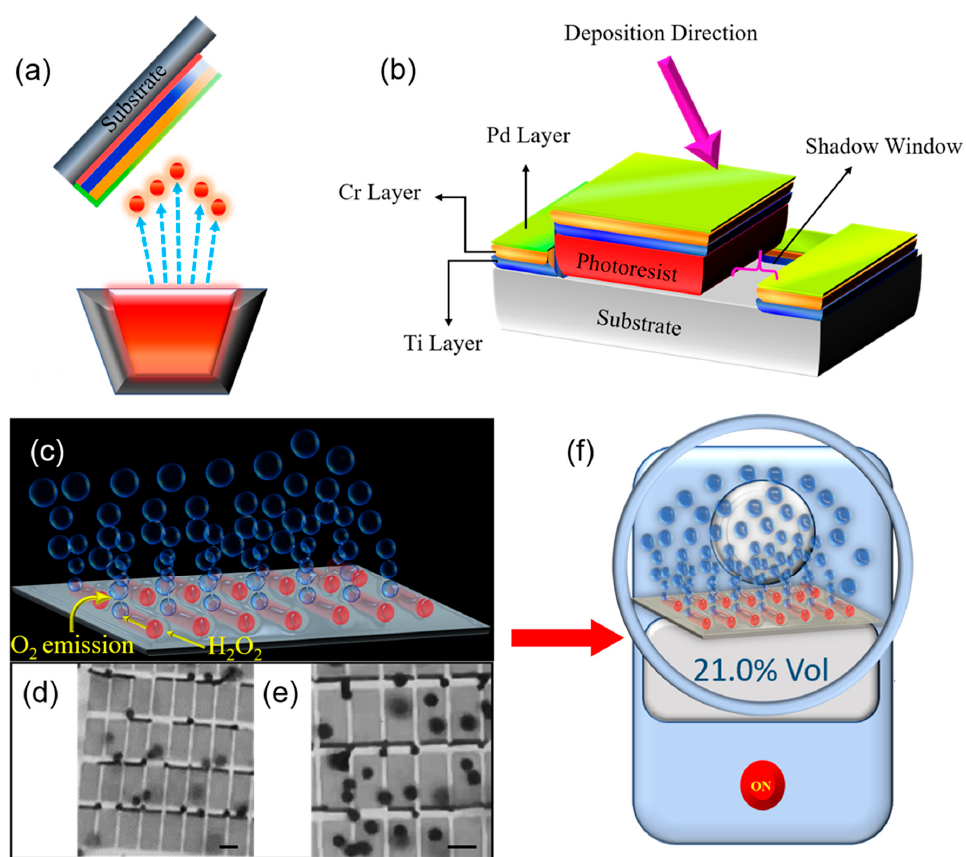
Figure 1. Oxygen generation using strain-engineered catalytic nanomembrane-based Ti/Cr/Pd microtubes; ( a , b ) Schematic representation of an angular e-beam deposition process; firstly the Ti layer (blue color), secondly the Cr layer (orange color) and thirdly the Pt layer (green color) are deposited on a sacrificial photoresist layer. ( c ) An illustration of microbubbles generation from tubular microreactor using decomposition of hydrogen peroxide into oxygen and water; ( d , e ) Optical microscopy images of rolled-up catalytic Ti/Cr/Pd microtube array integrated on Si substrate. The scale bars are 15 and 45 µm, respectively. The microtube’s oxygen bubbles generation in 8% v/v of hydrogen peroxide and 10% v/v Sodium dodecyl sulfate (SDS) surfactant; ( f ) Schematic image of oxygen concentration measurement by using an oxygen meter (in the air and in the closed volume of space containing an oxygen generator).